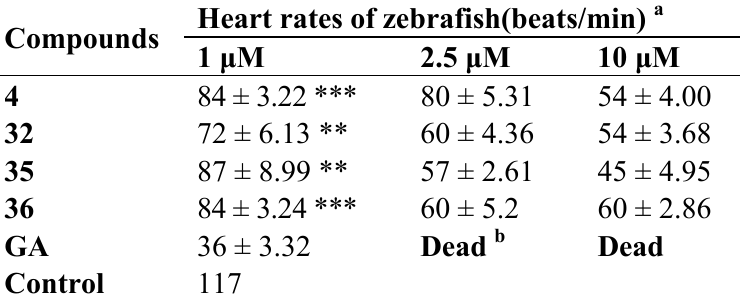
Table 2. The effects of 4 , 32 , 35 , 36 on heart rates of